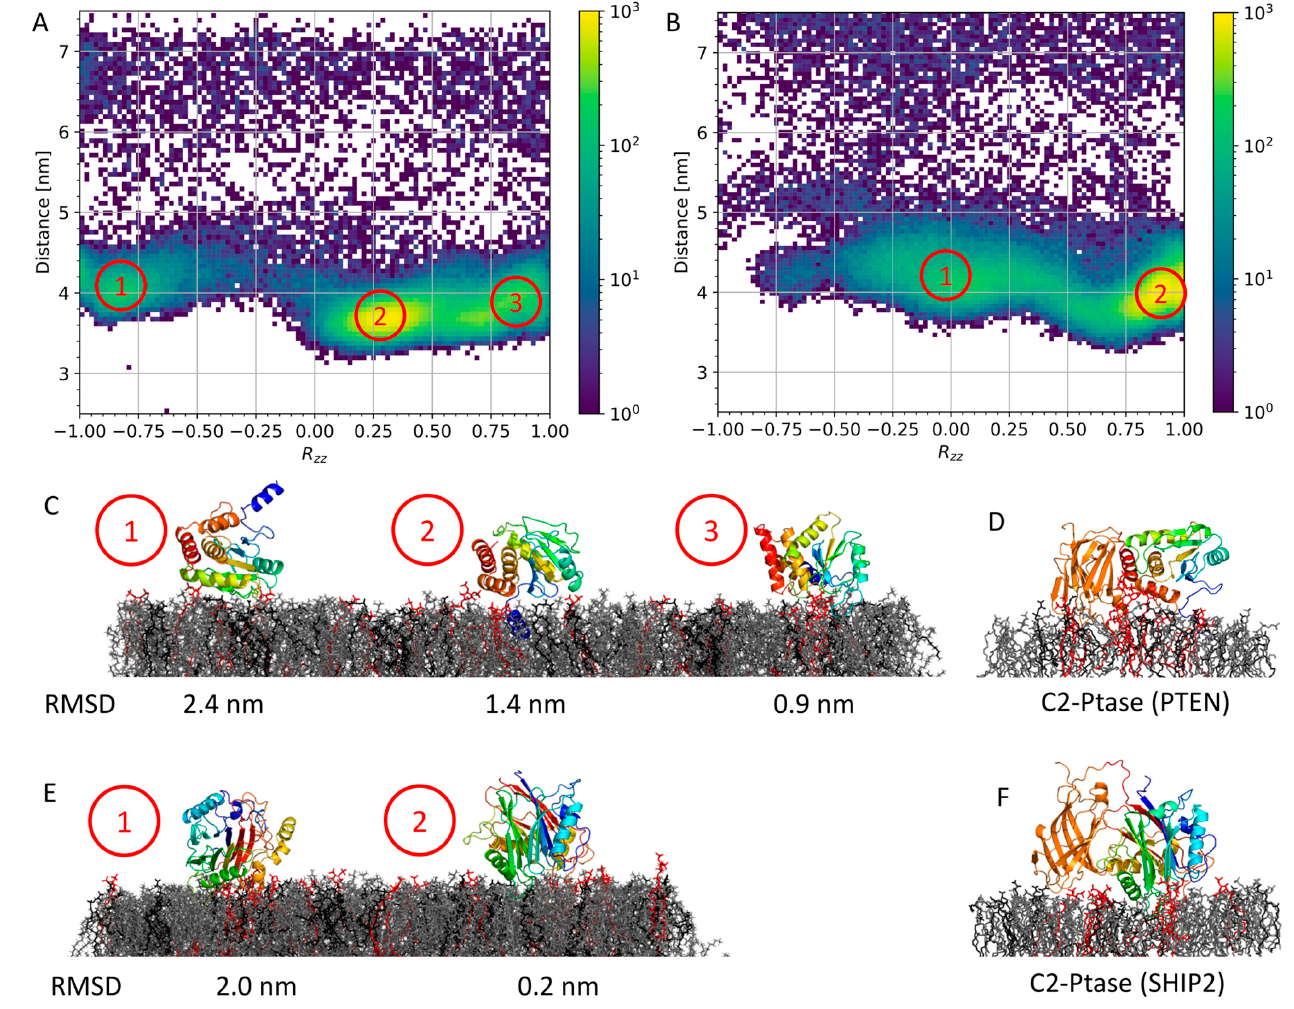
Figure 3. Simulations of isolated Ptase domains binding to lipid membrane: ( A ) Density map for 25 simulations of Ptase PTEN . The center-of-mass distance between Ptase PTEN and the lipid bilayer is plotted against the orientation with respect to Ptase of full-length PTEN. R zz = 1 means the orientation is the same, and R zz = − 1 corresponds to a 180 ◦ rotation. Dominant binding modes are numbered. ( B ) is as panel A but for simulations of Ptase SHIP2 . ( C ) Dominant binding modes for Ptase PTEN , with corresponding RMSD values with respect to Ptase of the full-length PTEN simulation. ( D ) Dominant binding mode for full-length PTEN. ( E ) Dominant binding modes for Ptase SHIP2 . ( F ) Dominant binding mode for full-length SHIP2. All proteins are shown in a rainbow color scheme, from blue in the N-terminus, over green, yellow, and orange to red in the C-terminus. PC lipids are gray, PS are black, and PIP 2 are red.